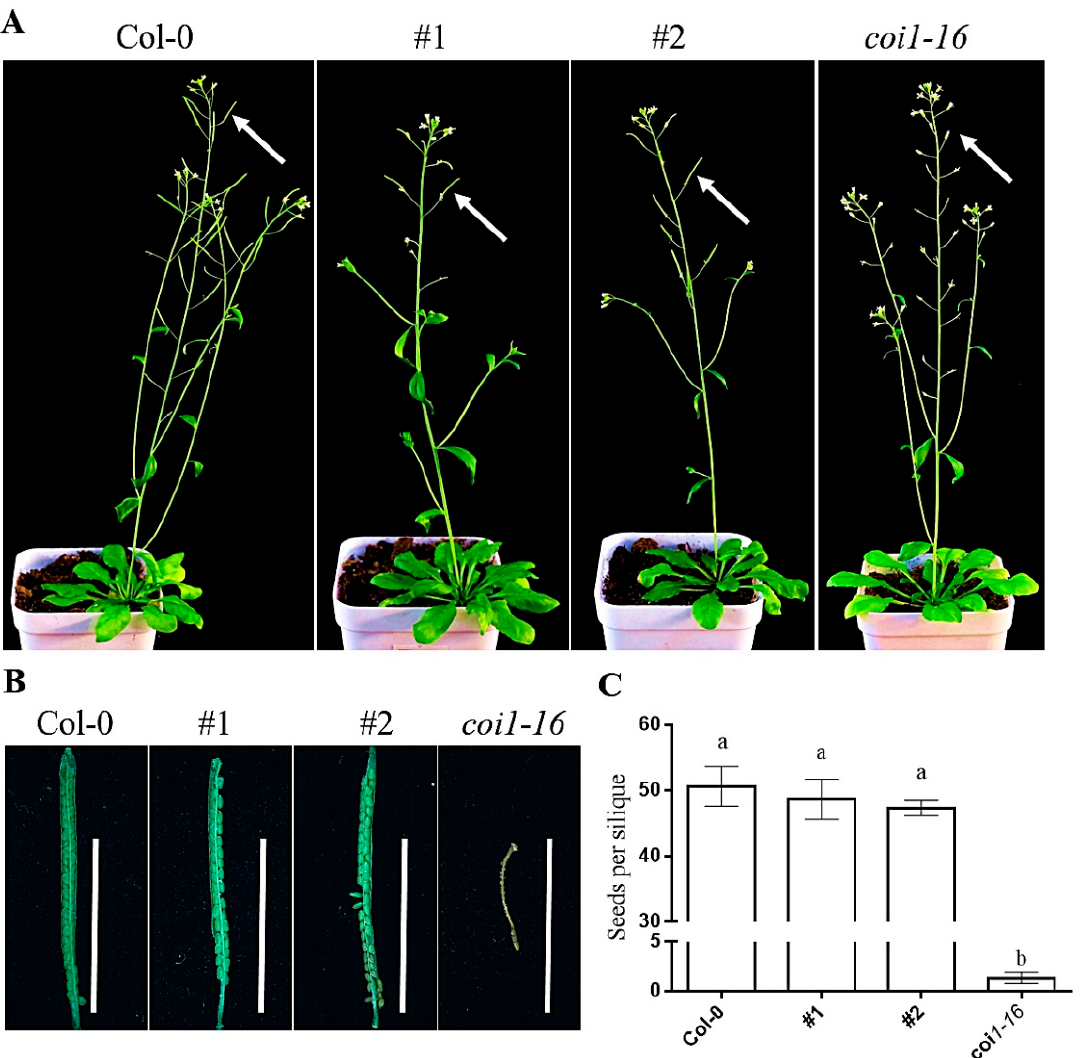
Figure 5. Phenotypes of Col-0, complemented lines #1 and #2, and coi1-16 mutant. Overall appearance of Arabidopsis thaliana plants of di ff erent backgrounds ( A ); close-up of fully developed siliques about 10 days after pollination ( B ); the fertility was determined by counting the seeds number per silique ( C ) ( N > 10). The error bar represents the mean ( ± standard error) of 10 independent biological replicates. Columns marked with di ff erent letters ( a – b ) are significantly di ff erent from the others (ANOVA followed by Tukey’s multiple comparison test ( p < 0.05)).